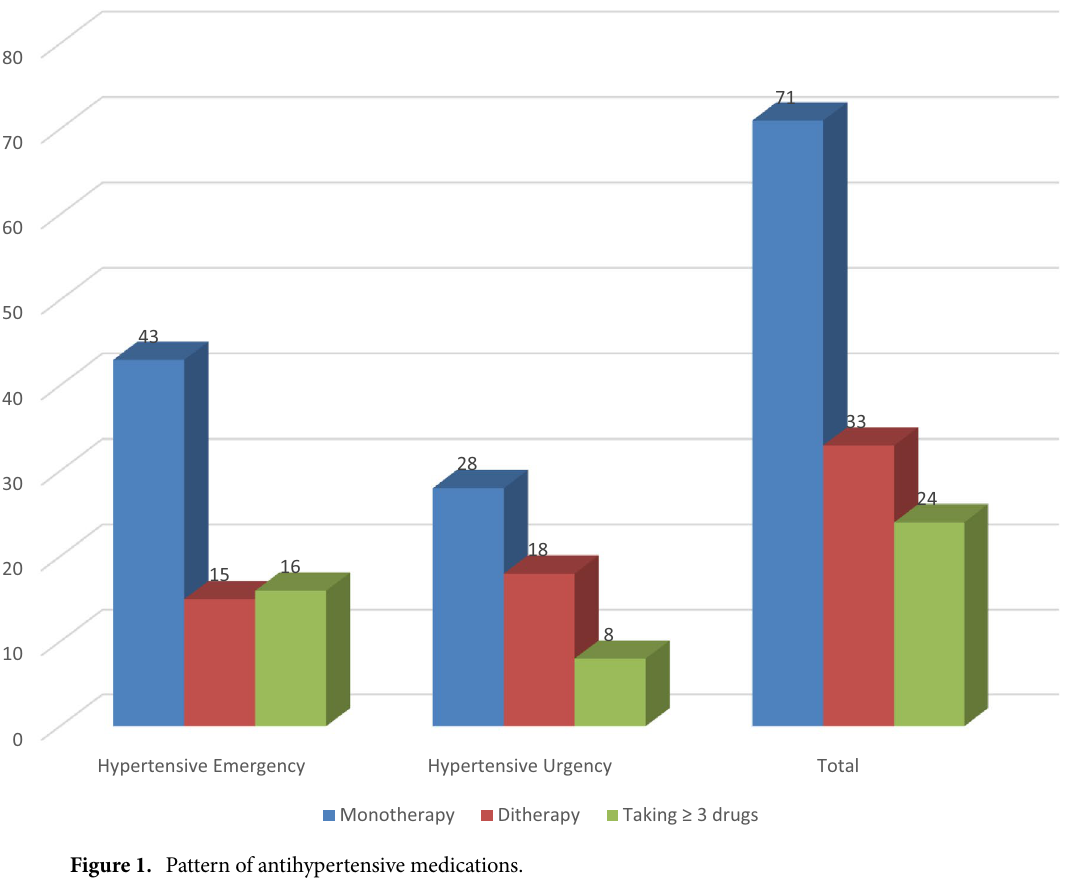
Figure 1. Pattern of antihypertensive